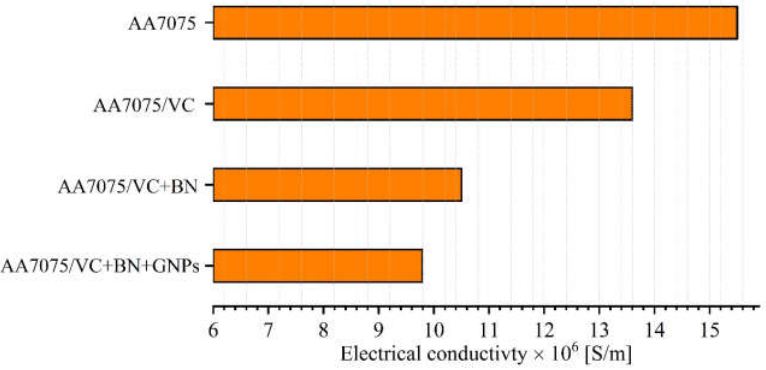
Figure 8. The electrical conductivity of the base alloy AA7075 and the manufactured composites.